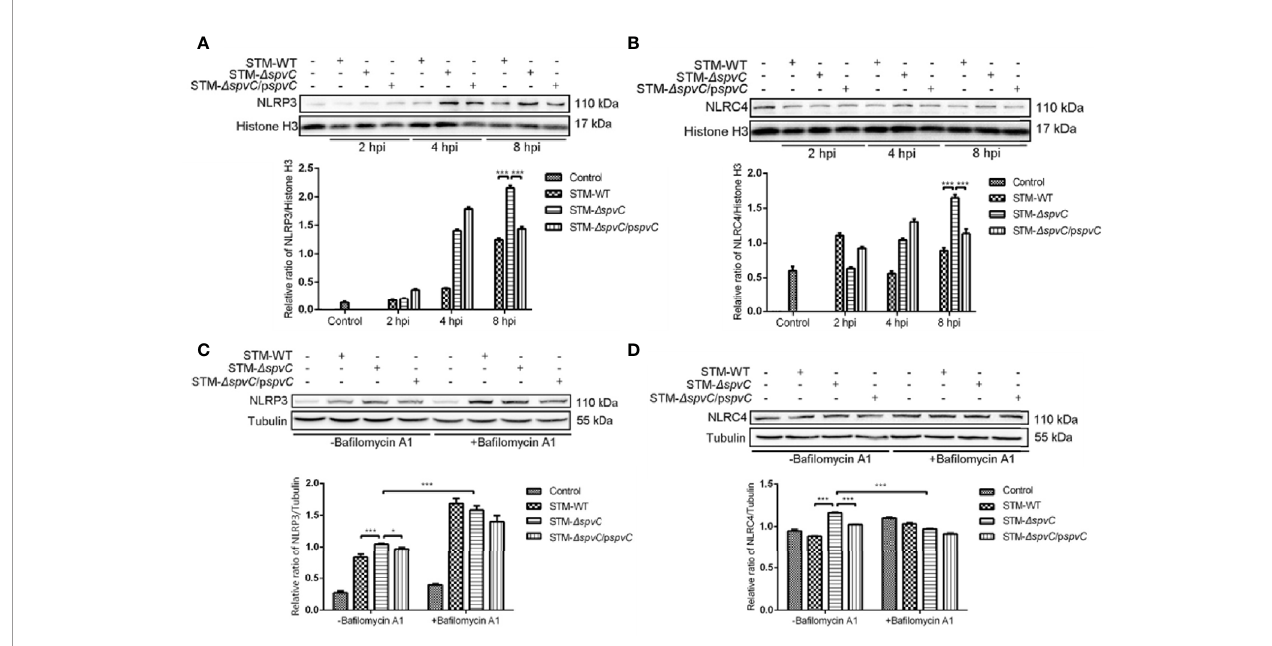
FIGURE 4 | spvC down-regulates NLRP3 and NLRC4 in an autophagy related manner. (A, B) J774A.1 cells were infected with STM-WT, STM- D spvC and STM- D spvC /p spvC at an MOI of 10. Cell lysates were analysed by western blot with speci fi c antibodies to NLRP3 (A) , NLRC4 (B) and the control Histone H3 at 2 hpi, 4 hpi and 8 hpi. (C, D) J774A.1 cells were infected with STM-WT, STM- D spvC and STM- D spvC /p spvC at an MOI of 10 at 8 hpi after being pretreated with Ba fi lomycin A1. Cell lysates were analysed by western blot with speci fi c antibodies to NLRP3 (C) , NLRC4 (D) and the control Tubulin. Data were compared by ANOVA. Values are expressed as the means ± S.D., n = 3. Statistically signi fi cant differences are indicated. *** P < 0.001; * P <